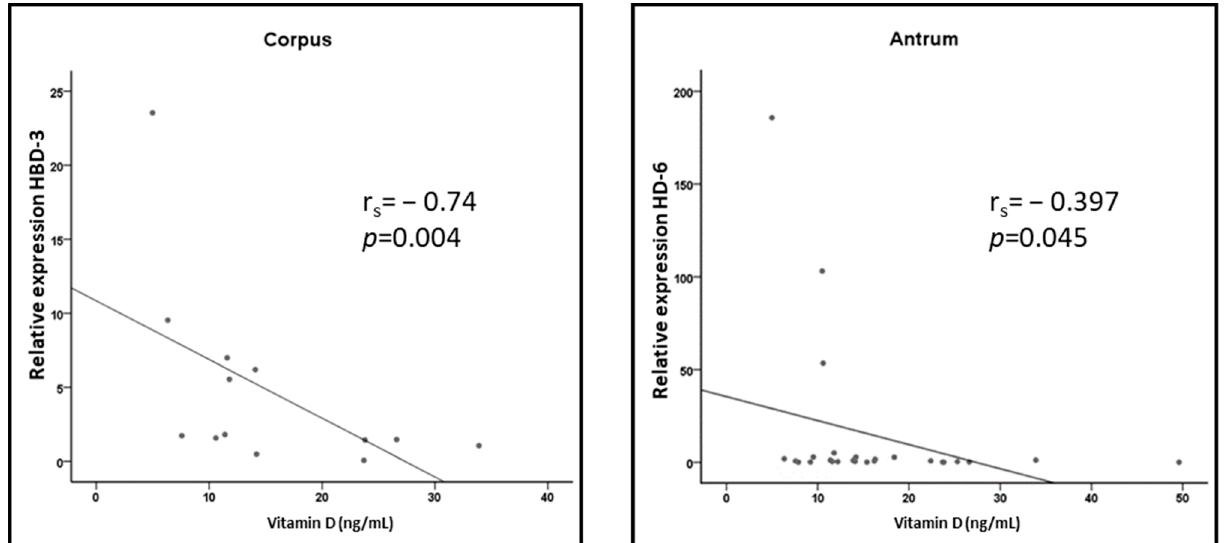
Figure 2. Scatter plot illustrating the correlations of vitamin D levels with the expression of HBD3 in the gastric corpus and HD6 expression in the gastric antrum.